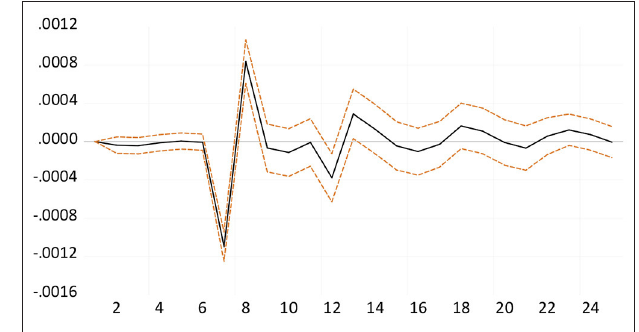
FIGURE 5 | Response of Y(MADEUR) to orthogonal impulse from X (COVID-19).